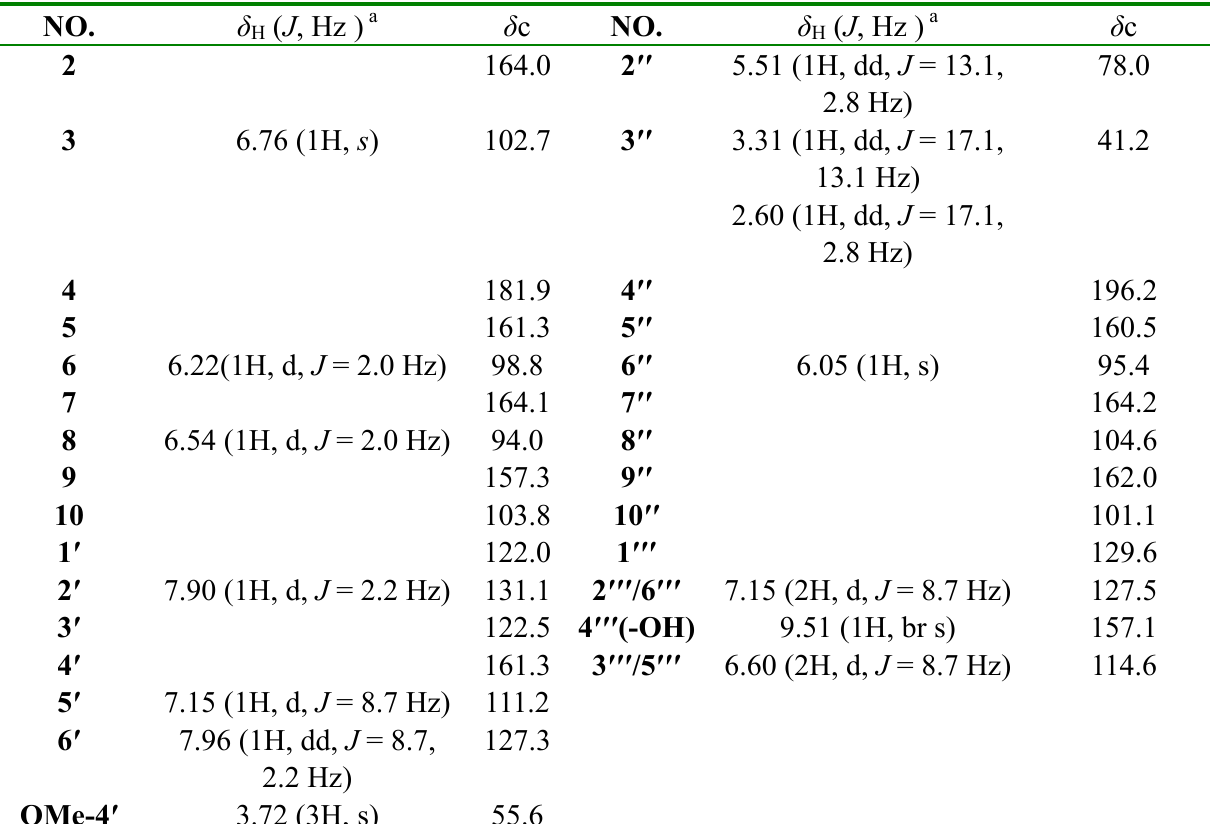
Table 1. 1 H- and 13 C-NMR spectral data of compound 1 (recorded at 400/100 MHz